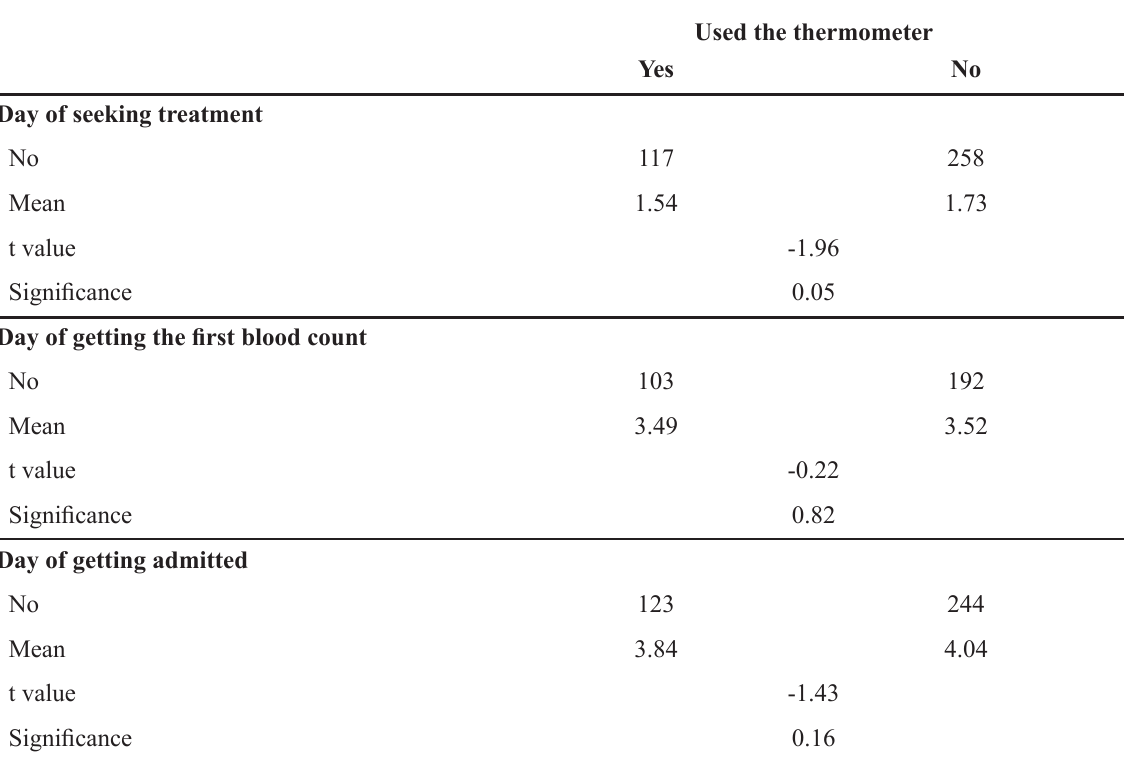
Table 4 Association between usage of thermometer and average number of days elapsed from the time of onset for selected aspects of treatment